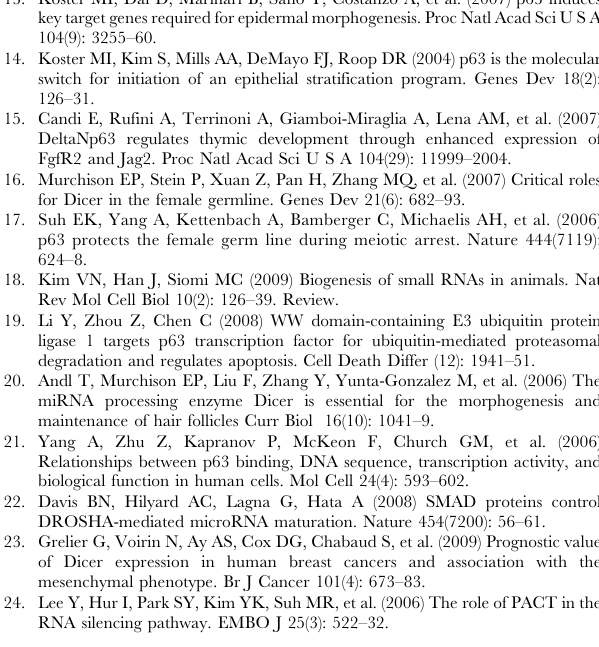
Table S3 p53-miRs that target more than one component of the miRNA processing